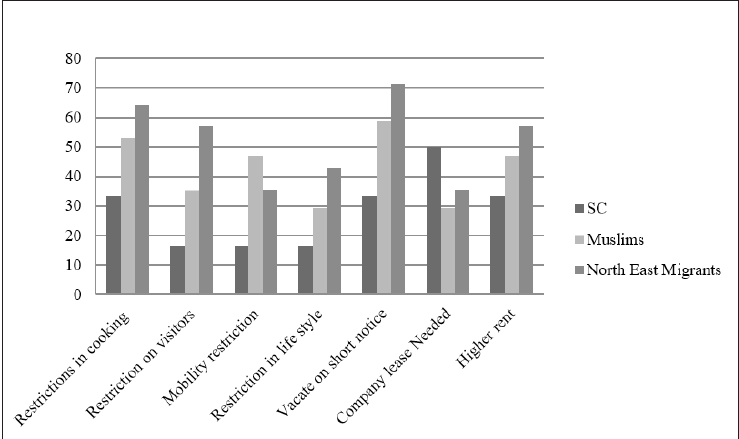
Fig 3. Conditions for Giving House on Rent Source: Primary Field Survey